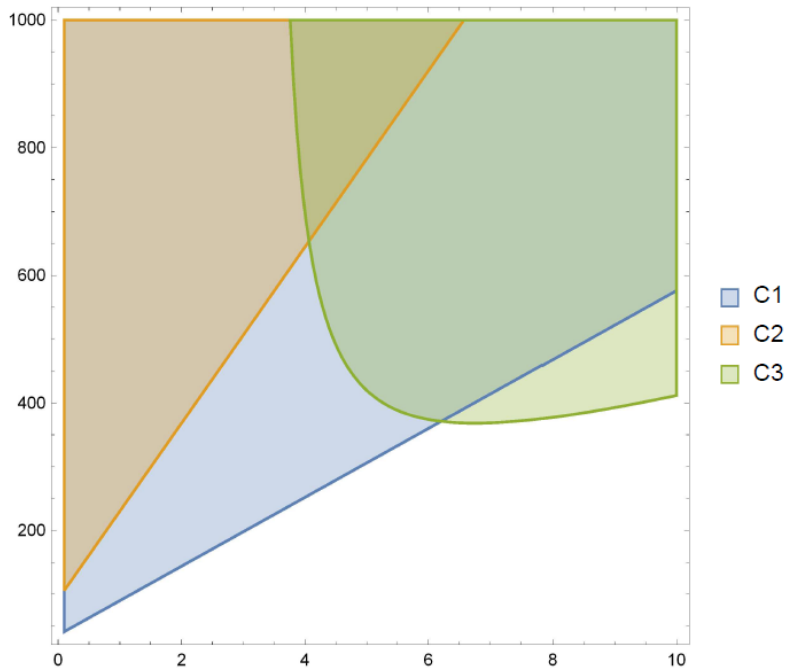
Figure 2. Regions for which Conditions (32)–(34) are satisfied when a = 2/3 and b =